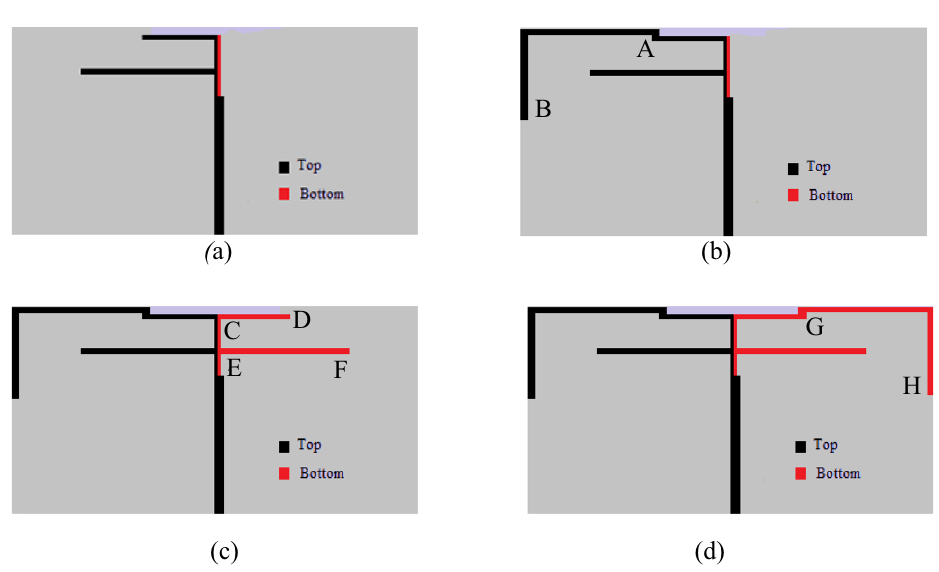
Figure 2. Four evolution stages of the antenna design ( a ) Ant-1, ( b ) Ant-2, ( c ) Ant-3, ( d ) the proposed antenna.